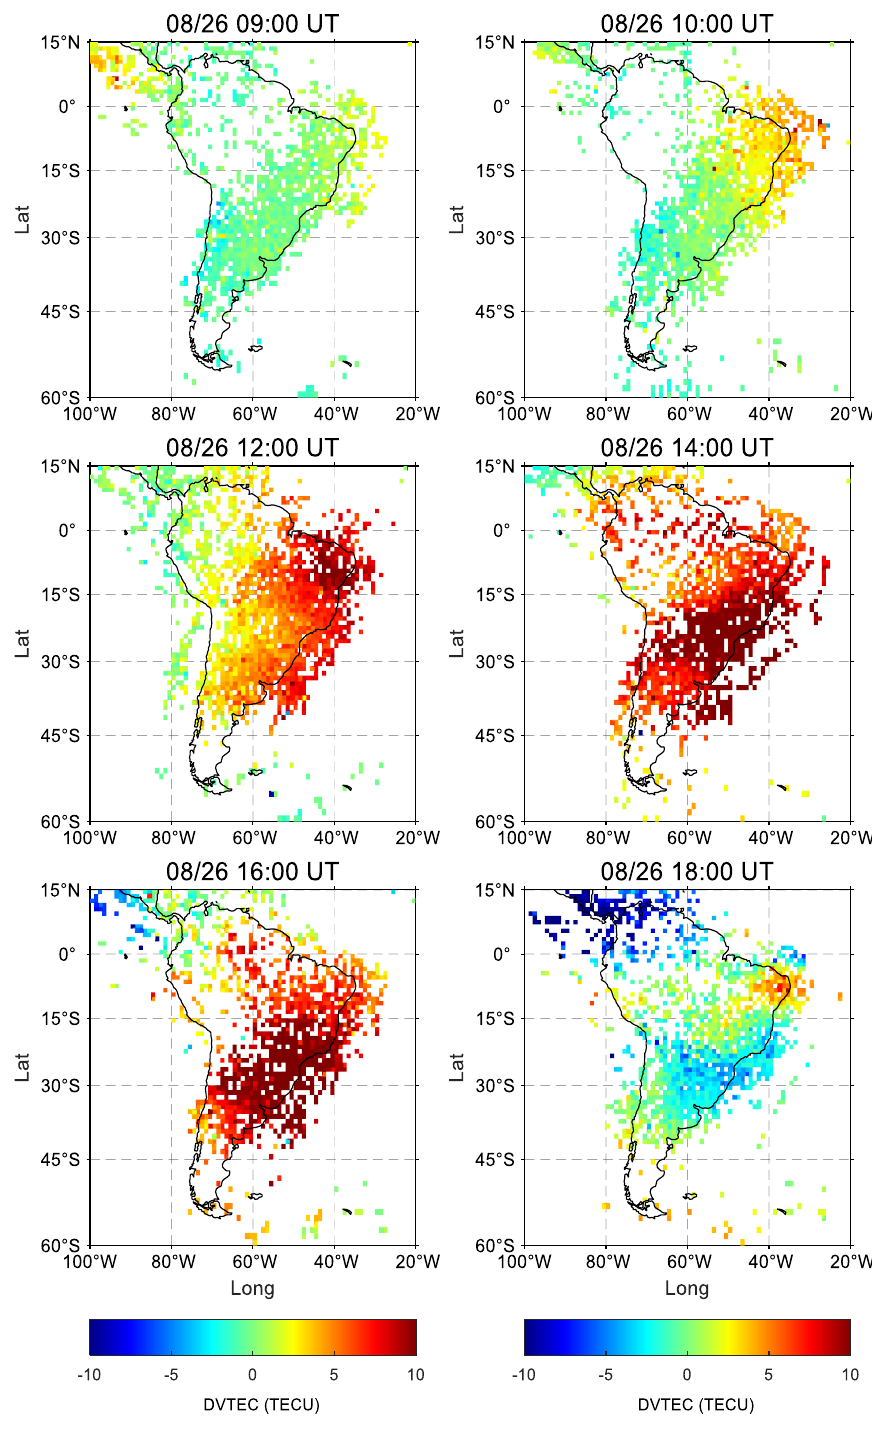
Figure 5. Spatiotemporal evolutions of storm-2.